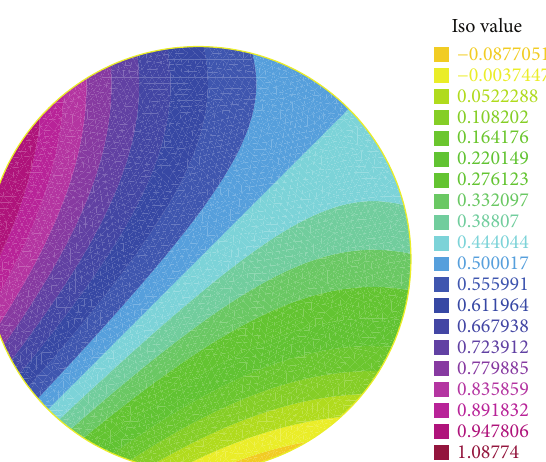
Figure 2: The numerical solution.